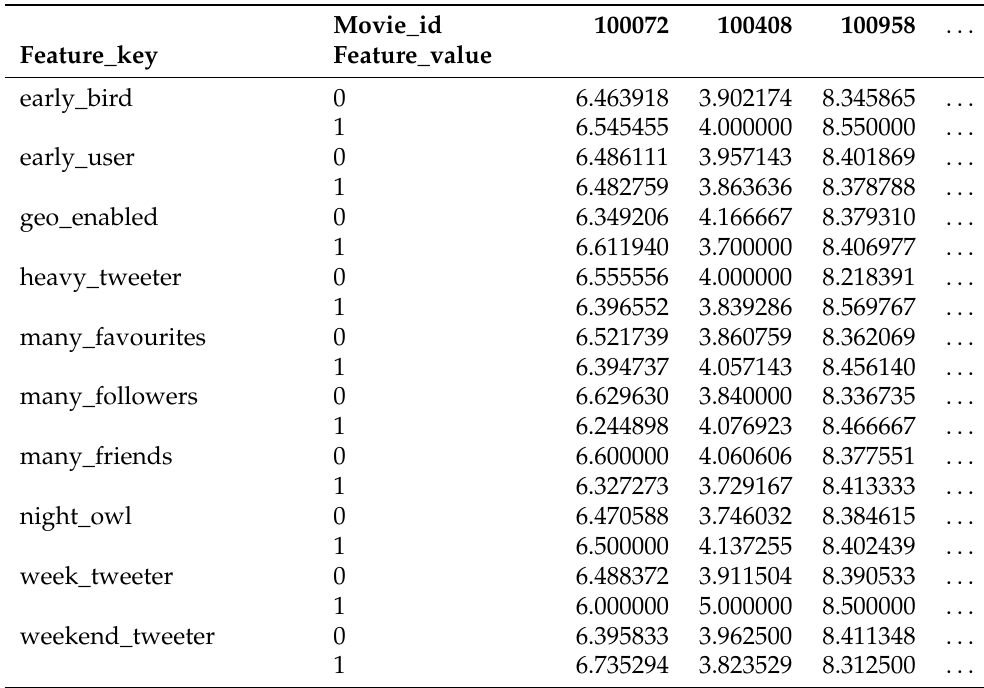
Table 1. Dataframe feature ratings matrix, including the average rating per movie for all different user feature values. The shape of the matrix is (20, 2831), where 20 is the different user feature values, and 2831 is the number of movies after filtering movies without enough ratings.